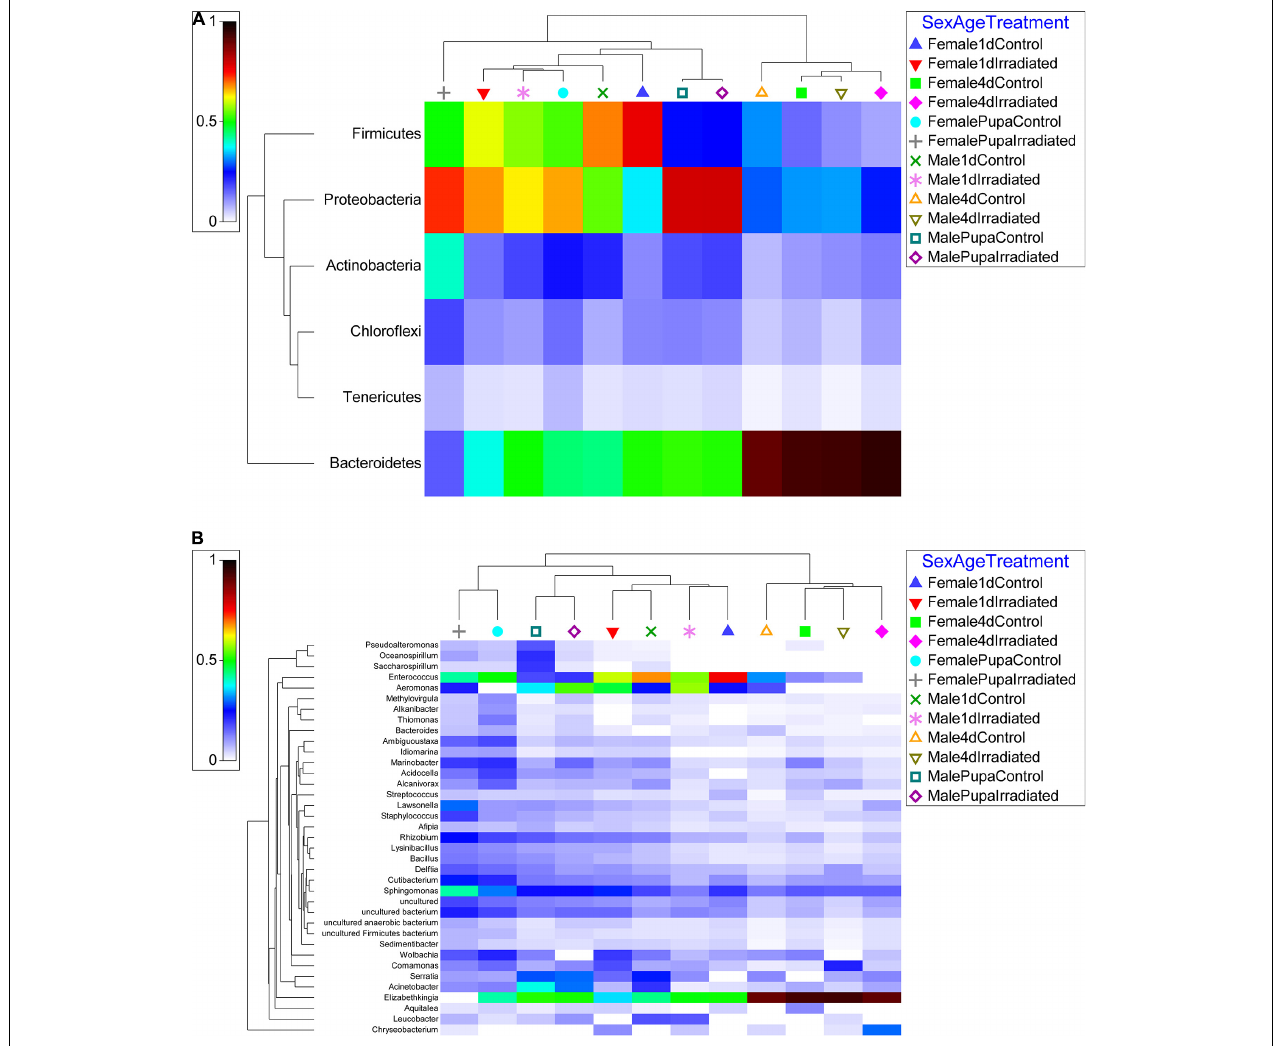
FIGURE 2 | Relative abundance heatmap of the most dominant phylum and genus of all samples examined. (A) Phylum level. (B) Genus level. OTUs abundance results from qiime2 analysis were transformed with square root transformation and averaged based on the number of replicates per sample. The resemblance matrix was conducted with Bray Curtis similarity of the OTUs abundance